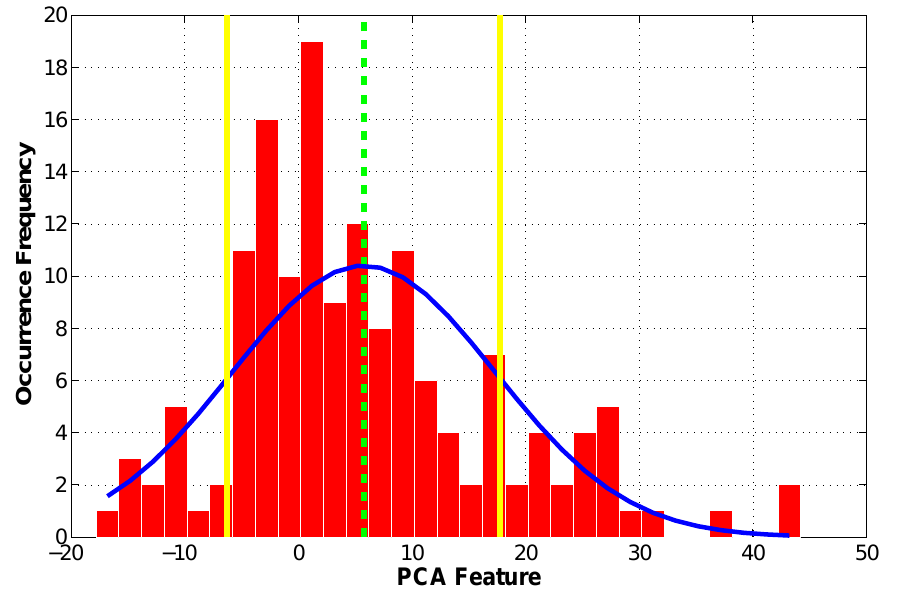
Figure 4. Histogram of PCA feature and its control